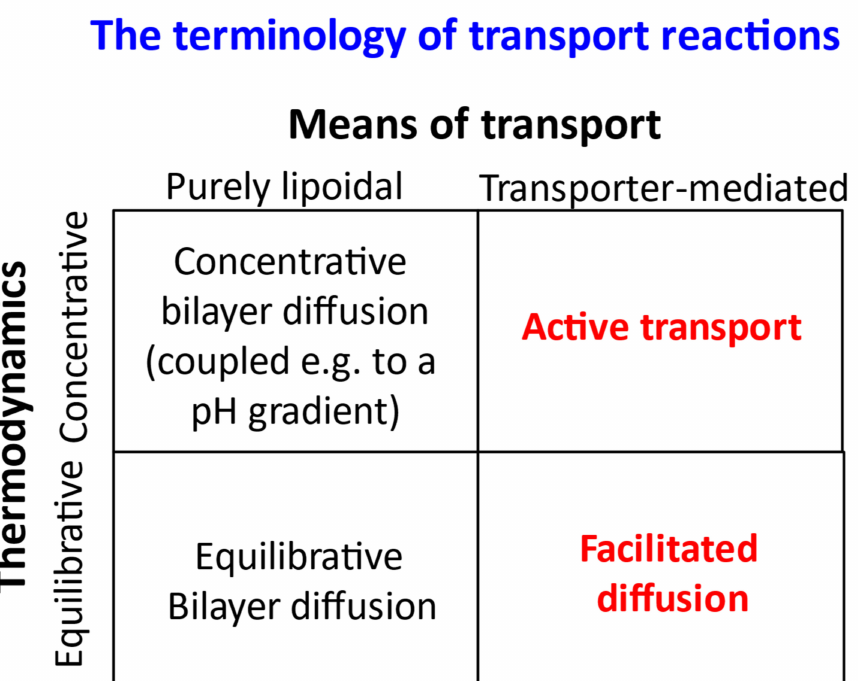
Figure 3. Suggested terminologies to avoid the use of the term “passive”, which is still widely misused to conflate two entirely separate concepts, one thermodynamic (hence independent of mechanism) and one